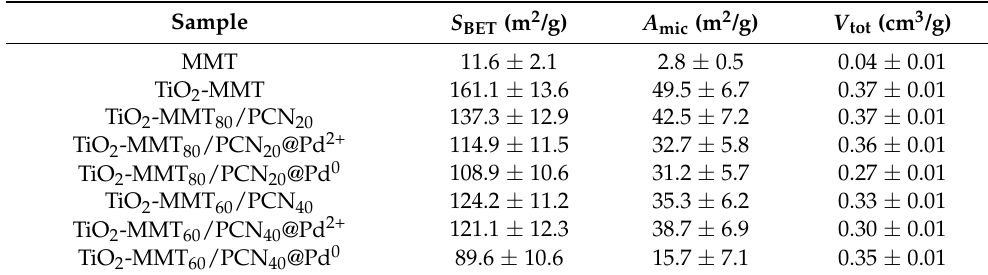
Table 1. Structural parameters of TiO 2 -MMT/PCN@Pd nanocomposites extracted from the isotherms in Figure